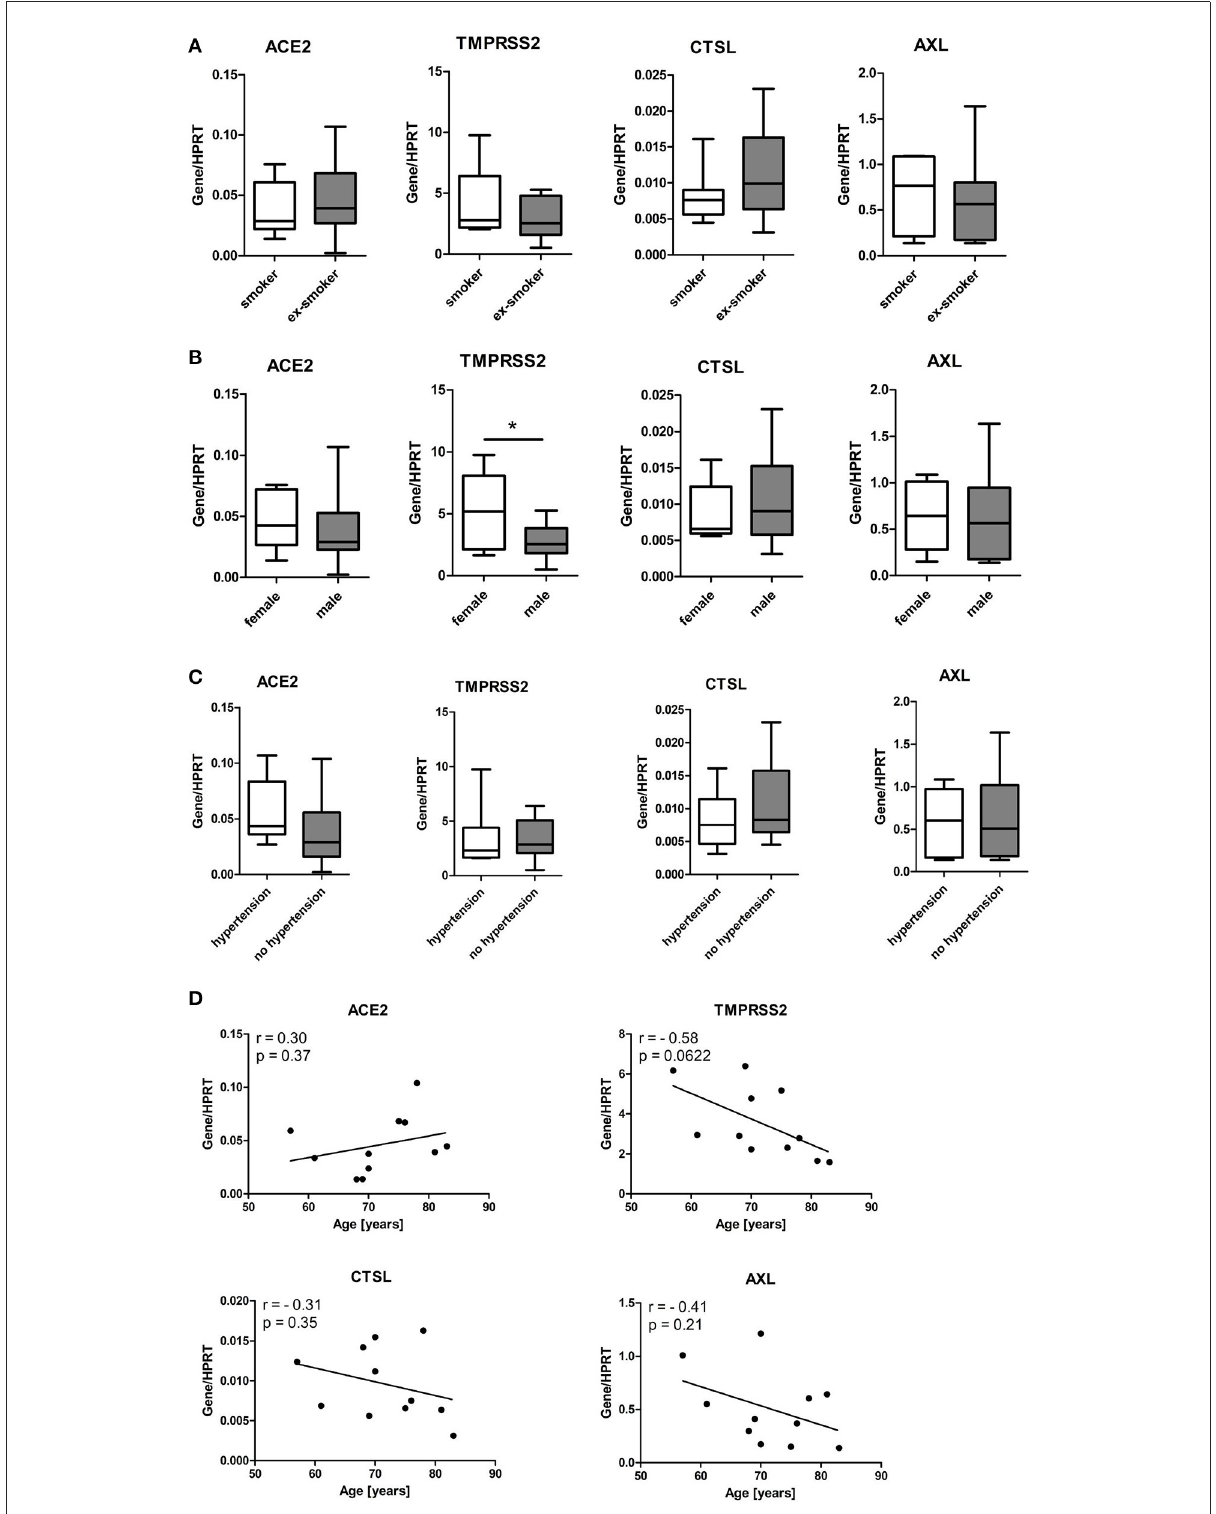
FIGURE4 Influence of smoking status, gender, age and hypertension of patients on expression of SARS-CoV-2 entry genes in SAEC. SAEC isolated from 11 lung cancer patients were ALI cultured. Gene expression was analyzed by LightCycler PCR and normalized to HRPT expression. (A) Comparison of gene expression of SARS-CoV-2 entry genes between current smokers (3 patients, 7 cultures) and ex-smokers (8 patients, 11 cultures).